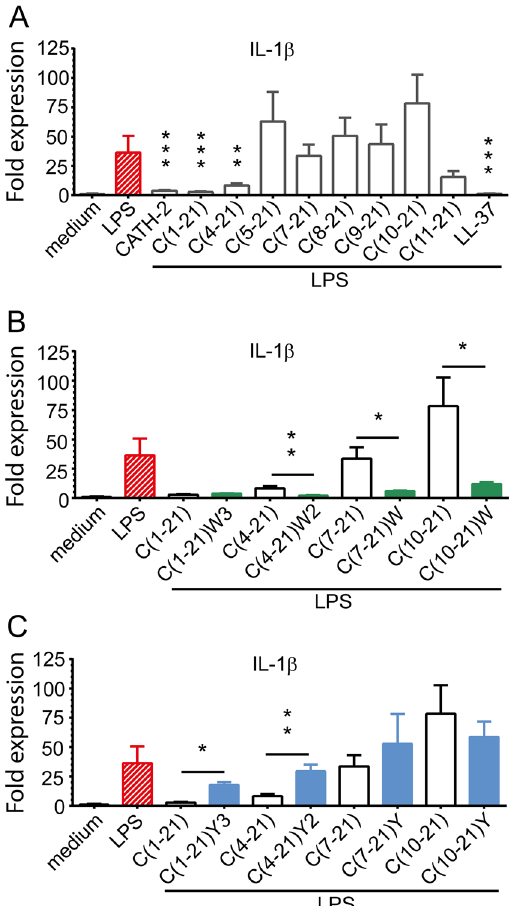
Fig 4. Neutralization of LPS-induced pro-inflammatory cytokine production by CATH-2 analogs. IL-1 β transcription in HD11 cells stimulated with S . minnesota LPS (50 ng/ml) and CATH-2 derived peptides (20 μ M). Transcription was measured by real time QPCR analysis after 4 h of stimulation. Amino acid substitutions: W3, [F2W, F5W, F12W]; W2, [F5W, F12W]; W, [F12W]; Y3, [F2Y, F5Y, F12Y]; Y2, [F5Y, F12Y]; Y, [F12Y]. a LPS-induced IL-1 β transcription in HD11 cells was blocked by full-length peptide and N- terminally truncated C(1 – 21) analogs up to 18 amino acid residues. b Phe/Trp substitution improved the capacity to neutralize LPS-induced IL-1 β transcription of peptides C(1 – 21) and C(4 – 21) and introduced LPS- neutralizing capacity in formerly inactive peptides C(7 – 21) and C(10 – 21). c Phe/Tyr substitution of active peptides C(1 – 21) and C(4 – 21) abrogated neutralization of LPS-induced IL-1 β expression. Data from 3 to 4 independent experiments; means ± SEM. * p < 0.05, ** p < 0.01, *** p <